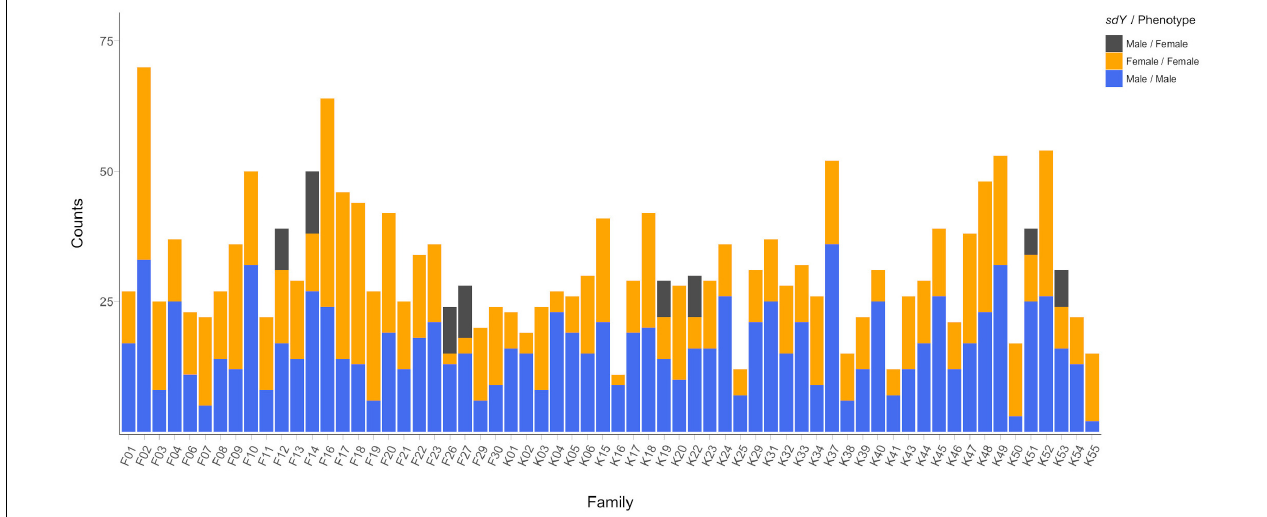
FIGURE 1 | Phenotypic sex frequencies distribution across the 64 studied families showing PCR-based sdY genetic sex concordances. Concordant males and females are displayed in blue and orange, respectively. Discordant females ( sdY positive phenotypic females) are shown in dark